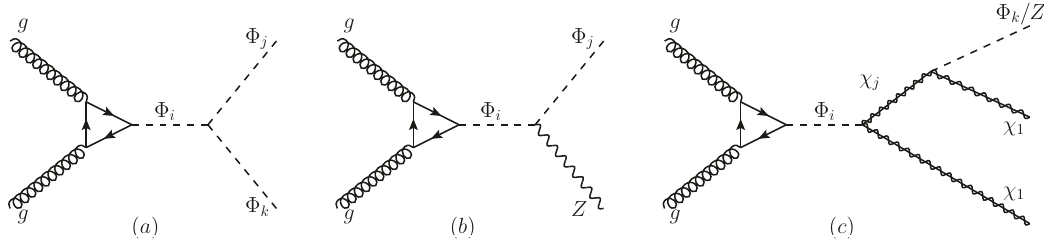
Figure 3 . Illustration of NMSSM-speci(cid:12)c Higgs decay channels, where the (cid:8) i;j;k stand for one of the (cid:12)ve NMSSM Higgs bosons. For channel ( a ), either one or all three of the (cid:8) i;j;k must be CP- even. For channel ( b ), if (cid:8) i is CP-even, (cid:8) j must be a CP-odd state, and vice-versa. For channel ( c ), the (cid:12)nal state can be (cid:31) 1 (cid:31) 1 h i , (cid:31) 1 (cid:31) 1 a i , or (cid:31) 1 (cid:31) 1 Z , and (cid:8) i can be CP-even or -odd. As discussed further in the text, the most important channels considered in this work are ( gg ! H ! hh 125 )